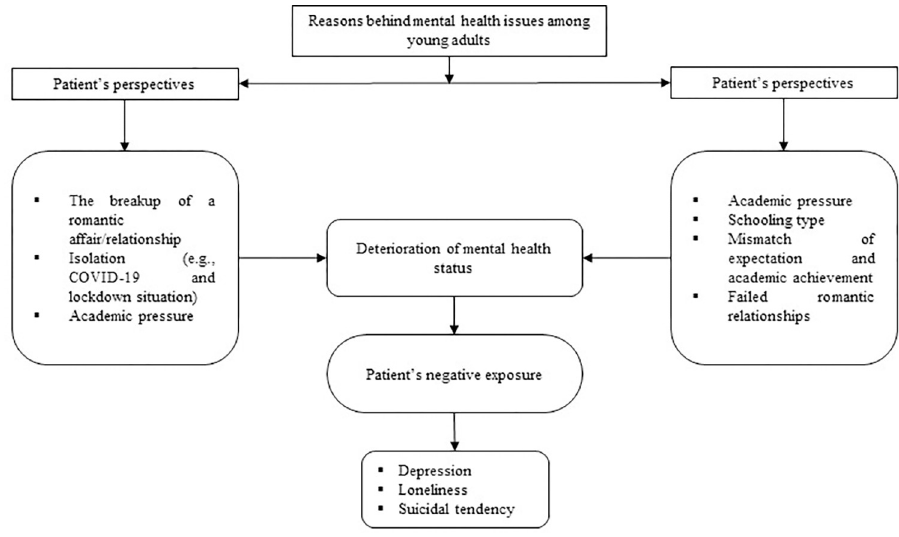
Fig 2. Thematic analysis of mental health issues among young